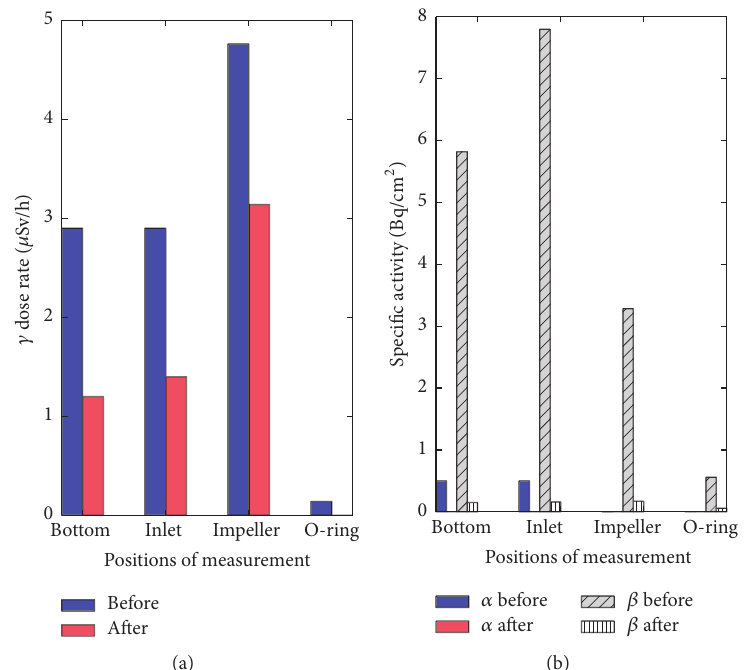
Figure 10: The radiation and contamination level of four helium circulator components before and after the decontamination. (a) 𝛾 dose rate; (b) 𝛼 and 𝛽 specific